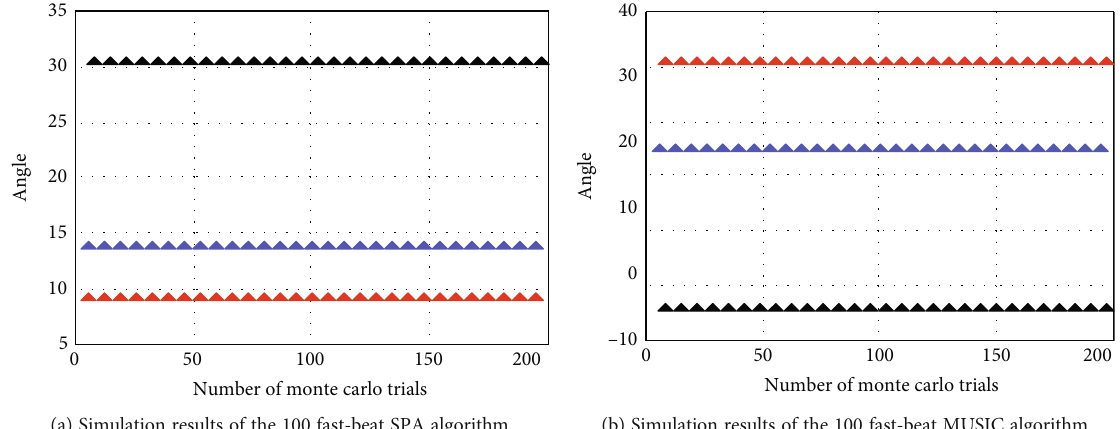
Figure 4: Comparison of DOA results of 100 snapshots.